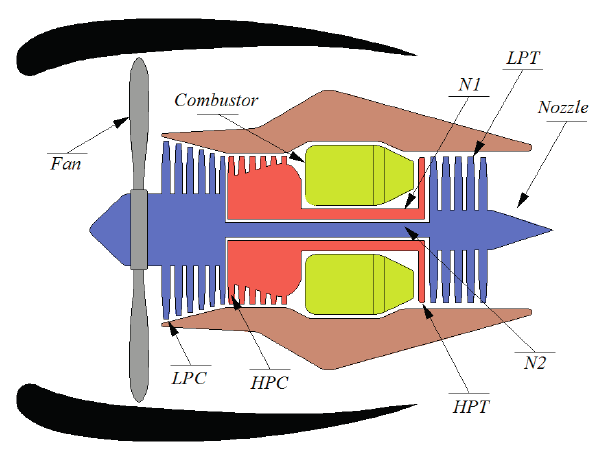
Figure 1. Simplified diagram of the engine simulated [13] (LPC: Low pressure compressor, HPC: High pressure compressor, LPT: Low pressure turbine, HPT: High pressure turbine, N1: Turbine axis and N2: Turbine